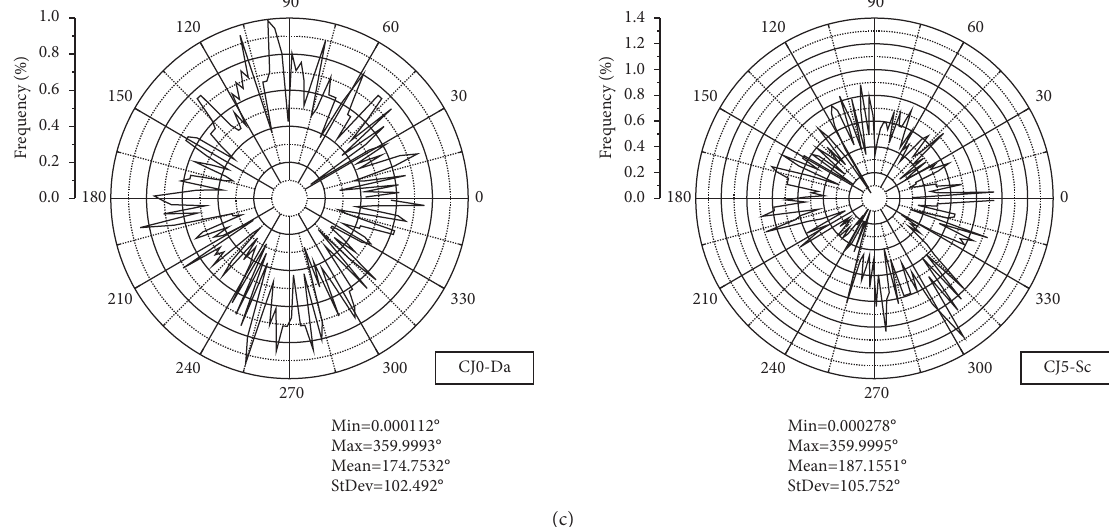
Figure 12: The frequency distributions of 3D spatial distribution parameters of fracture surface mesh elements of CJ0-Da and CJ5-Sc. (a) Asperity height. (b) Slope angle. (c) Aspect direction.